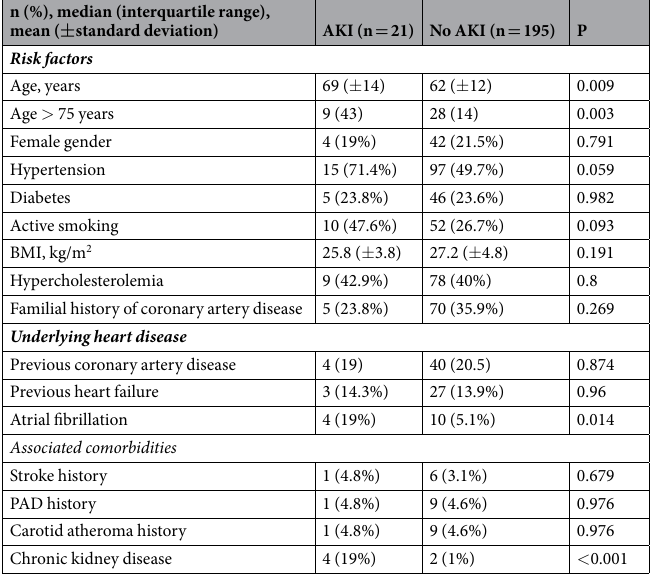
Table 1. Clinical characteristics of the population. AKI: acute kidney injury; No AKI: absence of AKI; BMI: body mass index (kg/m²); PAD: peripheral artery